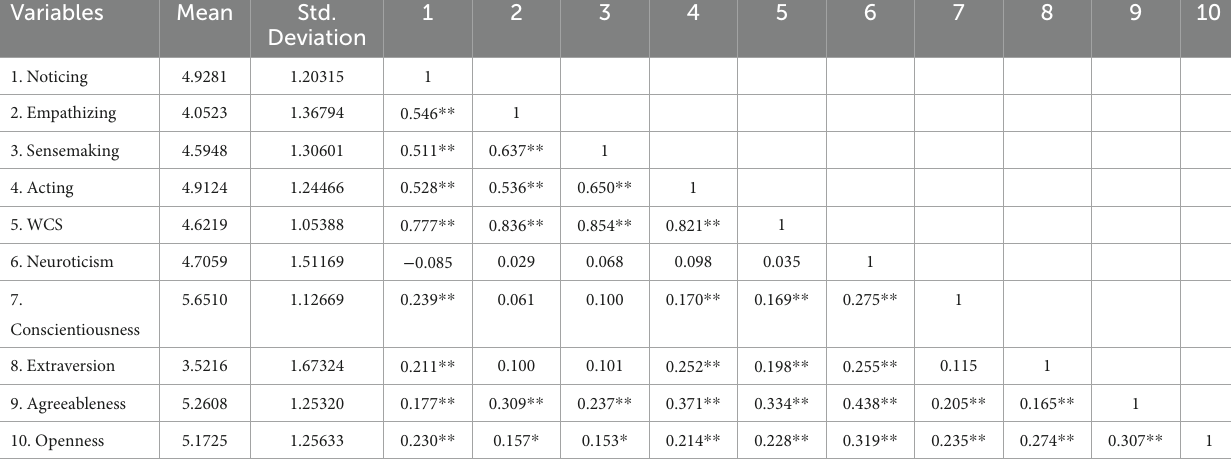
TABLE 11 Means, standard deviations, and correlations for personality correlates ( N = 255). Variables Mean Std.